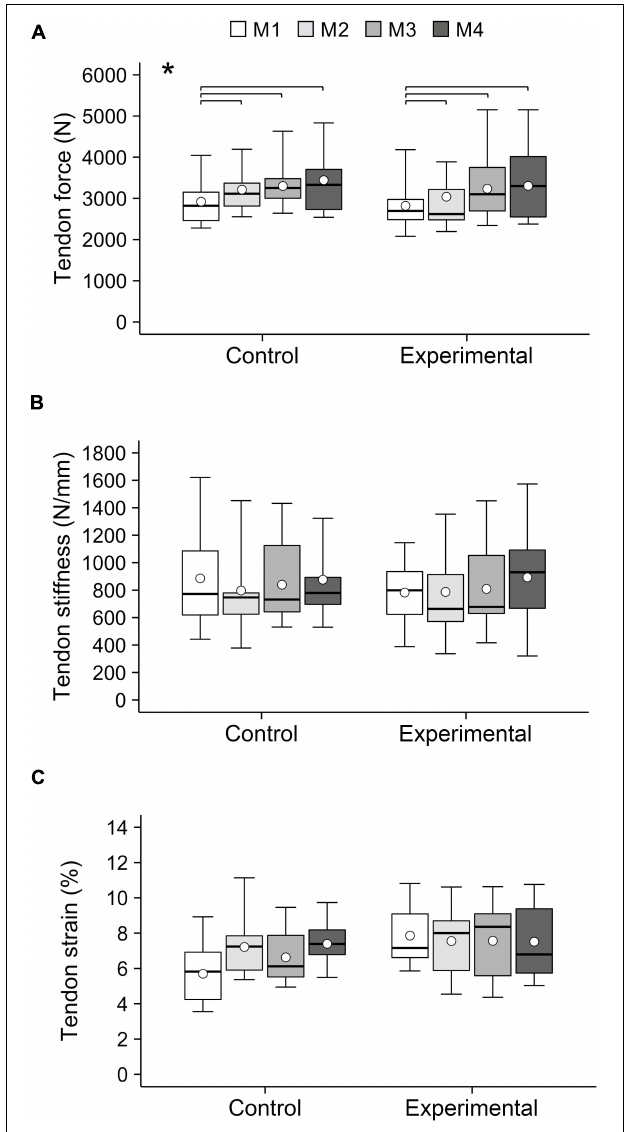
FIGURE 4 | (A) Maximum tendon force, (B) stiffness and (C) strain of the patellar tendon of adolescent handball athletes in the control and experimental group at the four measurement time points (M1–M4) over the season. Note that not all participants were able to attend all measurements. The given experimental data are shown in box-plots, while the average values predicted by the linear mixed model are shown in white circles. *Significant main effect of time ( p < 0.05). Significant post hoc comparisons are indicated by brackets ( p <